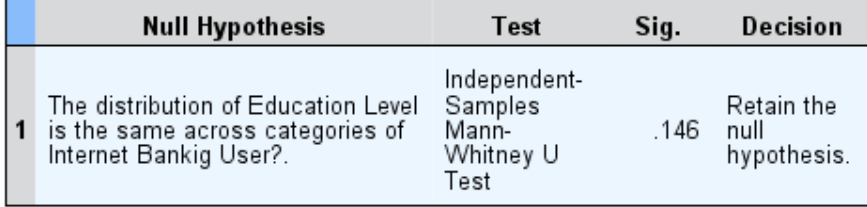
Figure 2. Independent Samples Mann-White U Test for non-parametric test education level group across internet banking users. Source: Author’s, using SPSS